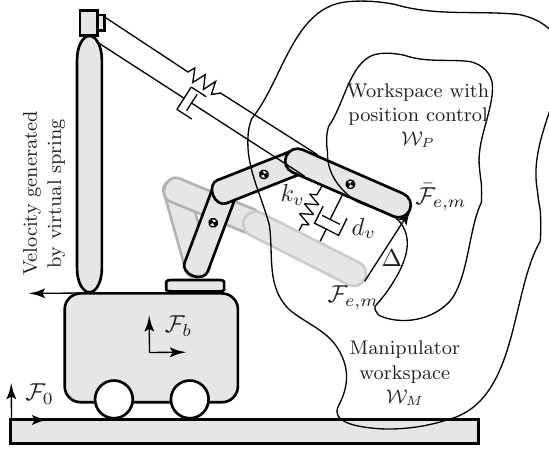
Figure 3: Definition of the workspaces in which the robot is controlled in the locomotion and ma- nipulation modes. Note that the workspace is defined for the manipulator arm with re- spect to the vehicle frame F b , and not the world frame F 0 . The velocity is generated by the virtual spring between the master manipulator (gray) and the slave manipu- lator (black).